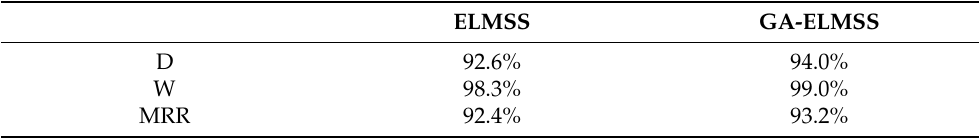
Table 8. Prediction accuracies of ELMSS and